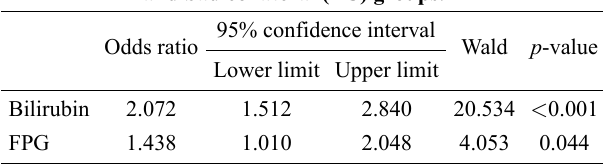
Table 4. Distinguishing factors in the good collateral (GC) and bad collateral (BC)